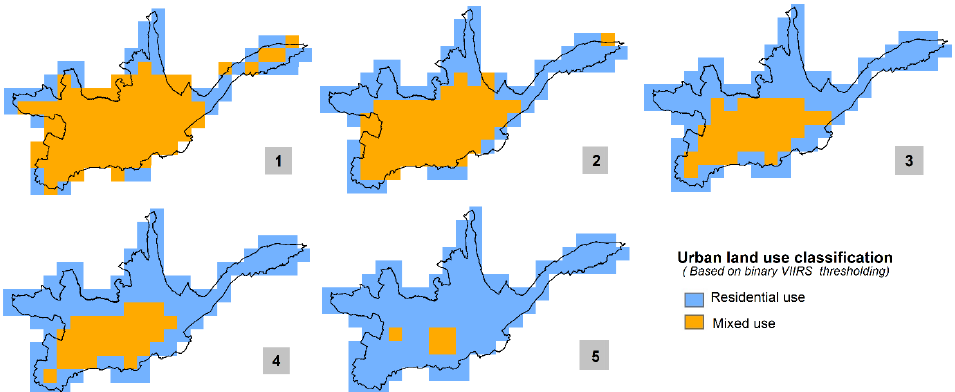
Figure 8. Binary land use classification of Cuenca City based on thresholds from aggregated VIIRS data (Table 3). Blue indicates residential and orange mixed use. Table record IDs are indicated in the figure as 1–5.